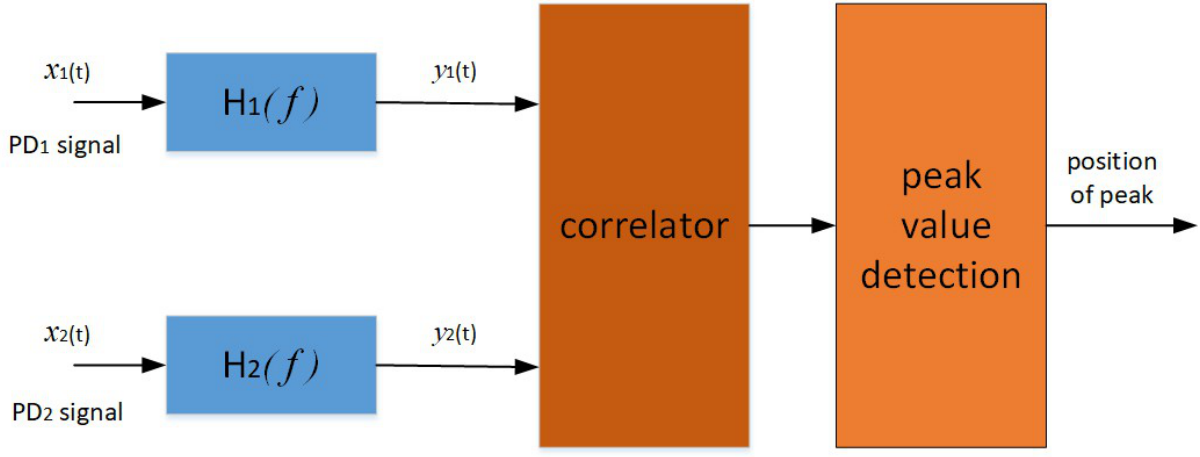
Figure 3. Flowchart of generalized cross-correlation